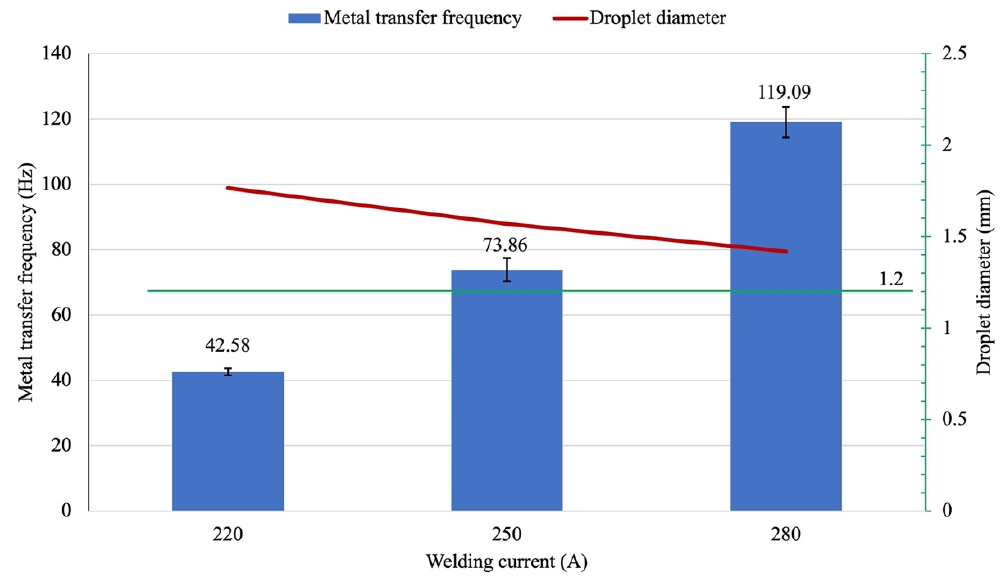
Figure 4. Metal transfer frequency and droplet diameter of metal ‐ cored wire.